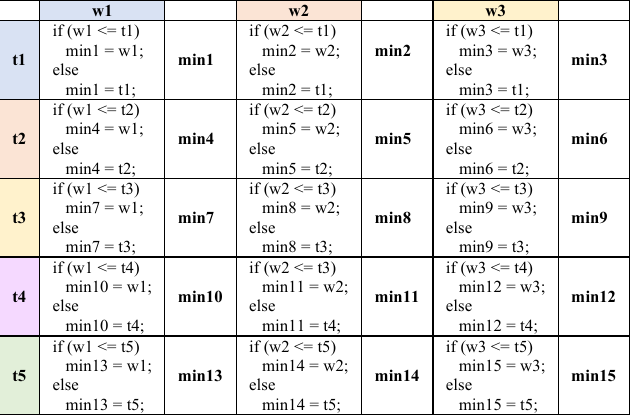
Figure 6. Matrix representation of the membership functions that relate, point to point, the variables of temperature and relative